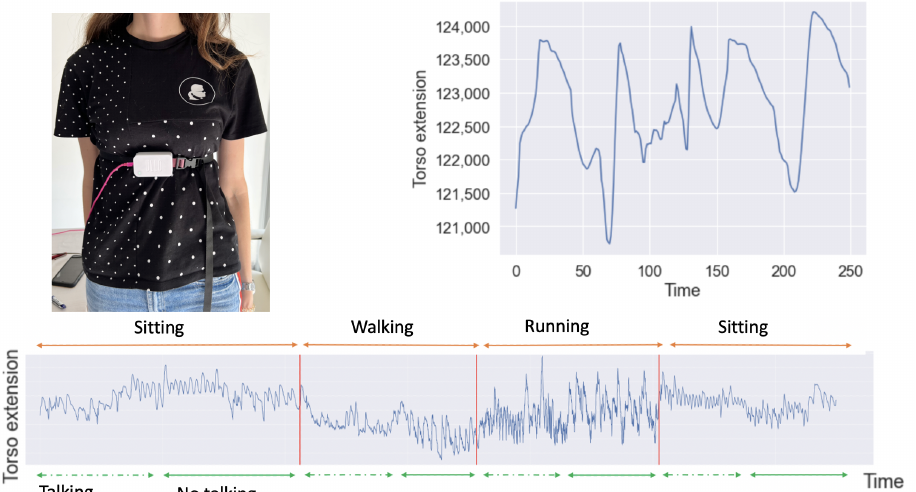
Figure 3. Participant wearing the “Alizé” respiration belt and the torso extension signals obtained during the